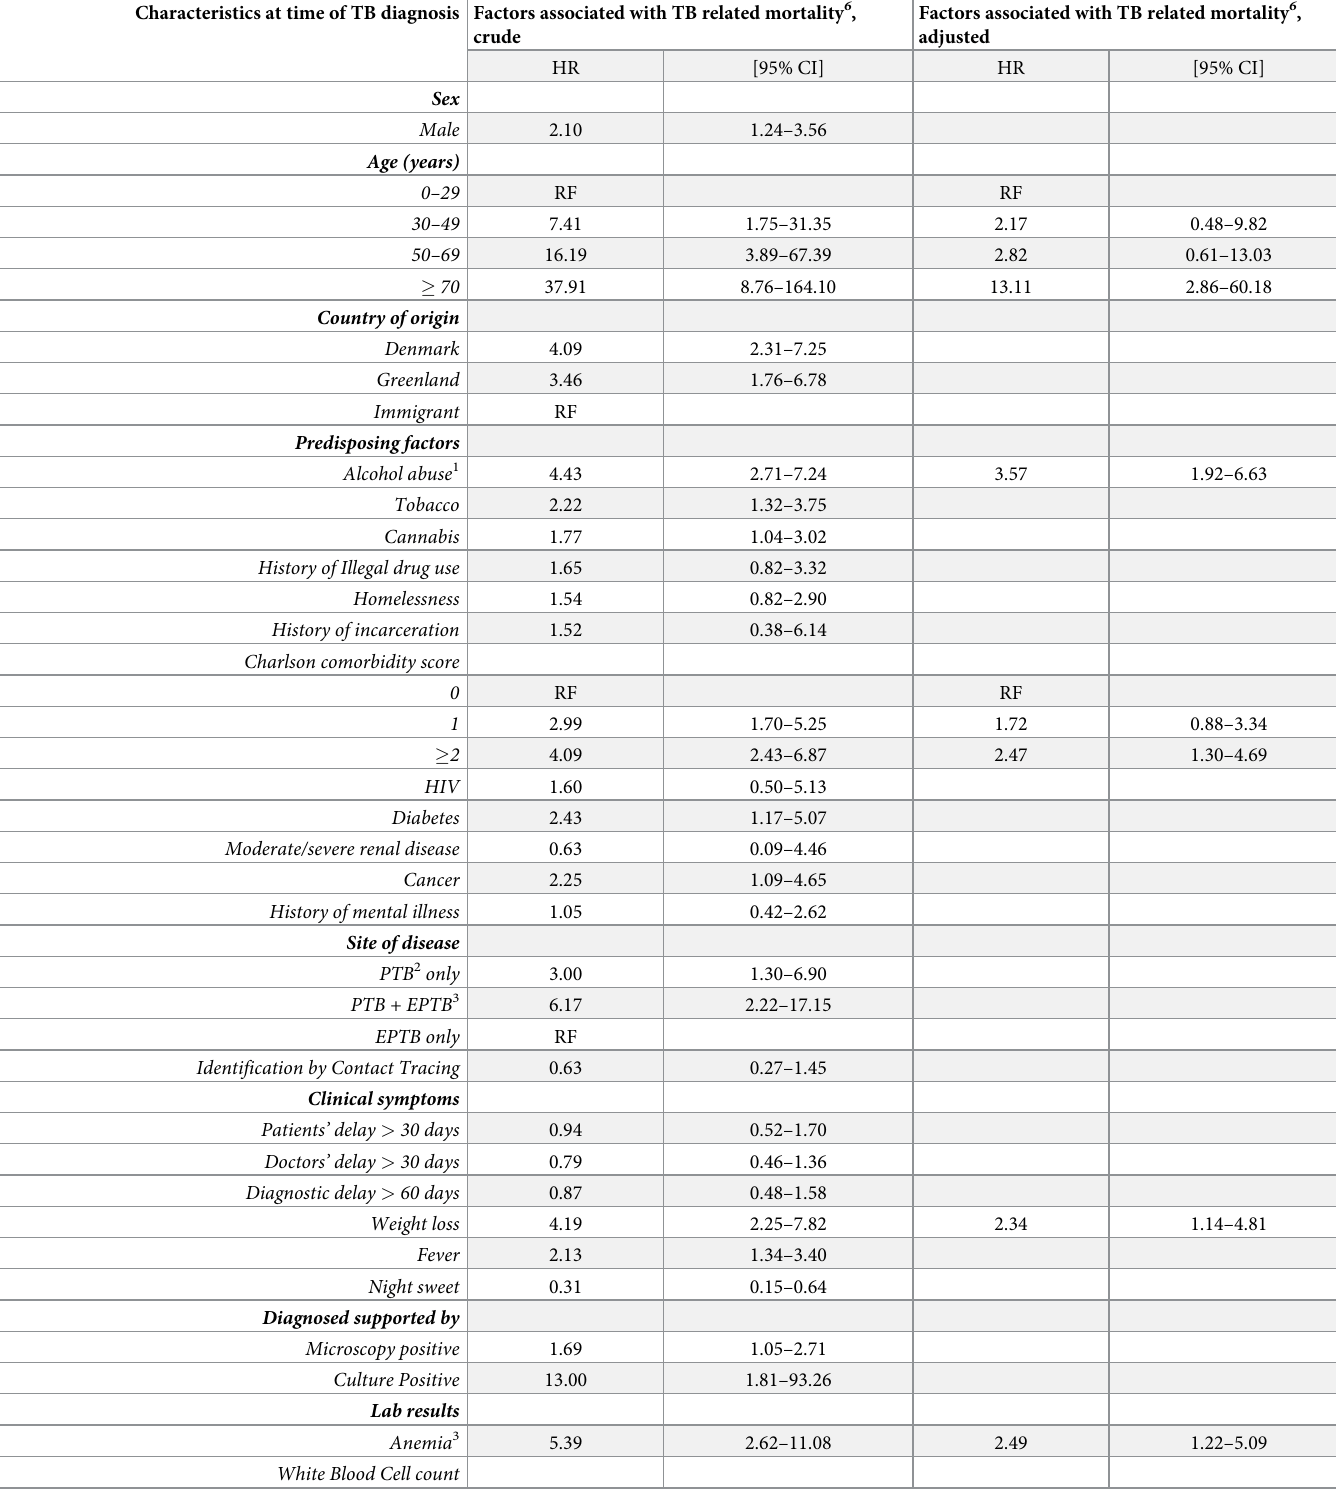
Table 3. Risk factors for tuberculosis related mortality, Denmark 2009–2014. Characteristics at time of TB diagnosis Factors associated with TB related mortality 6 ,